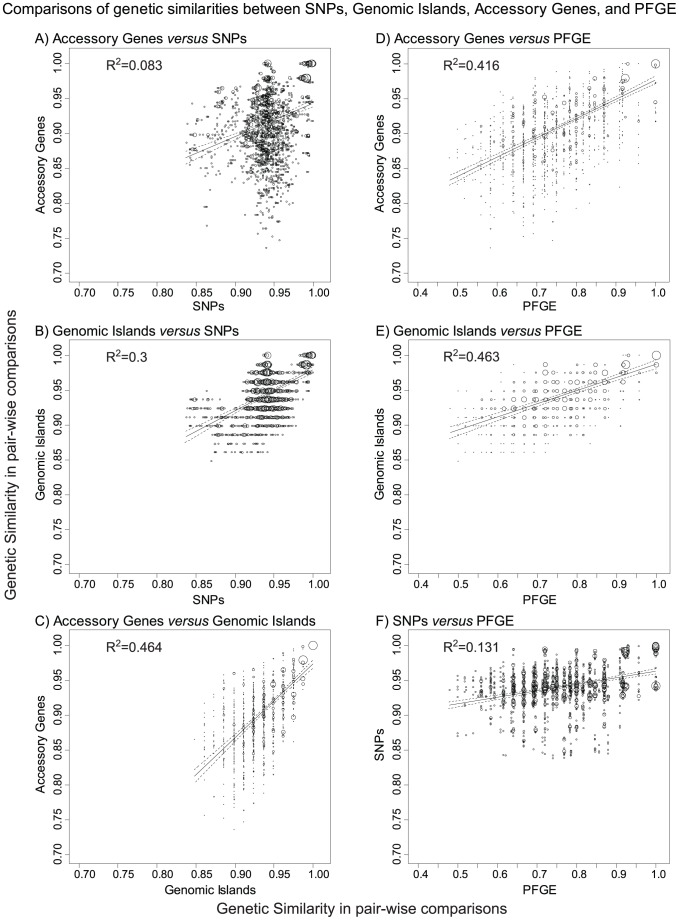
Comparisons of genetic similarities between core, non-repetitive, non-mobile SNPs, genomic islands, accessory genes, and PFGE bands.A–F) Plots of the frequencies of pairs of similarity scores for two matrices as indicated above each subplot. Matrices of the pair-wise genetic similarities were generated for UPGMA trees of the 72 new genomes in Bionumerics 6.5, and correspond to the interpretations provided in Dataset S1 (genomic islands), Dataset S3 (PFGE bands), Dataset S4 (SNPs), and Dataset S7 (accessory genes). The frequency of each pair of similarity values within a pair of matrices is indicated by circle size. A linear regression (solid line) with 95% confidence intervals (dotted lines) is shown for each pair of matrices as well as the coefficient of determination (R
2). All comparisons were statistically significant in Mantel tests of the paired matrices, with p≤10−4 except for part A, where p = 5×10−4.